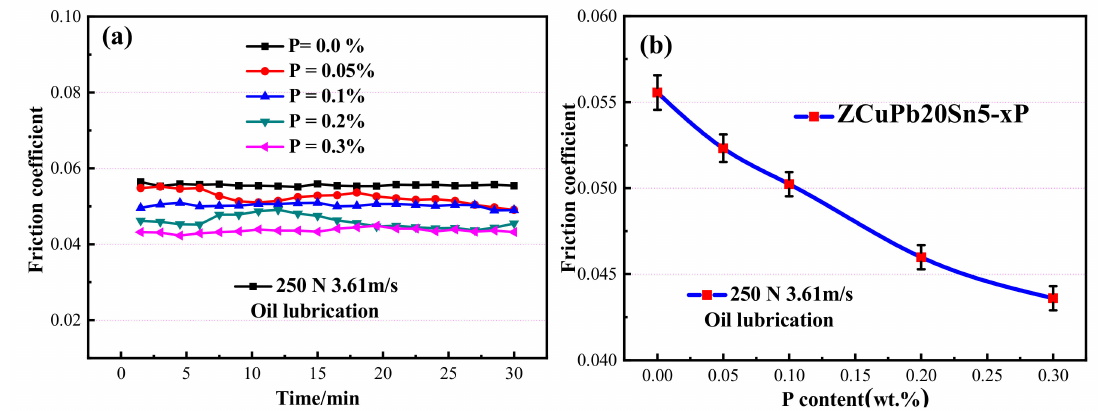
Figure 1. Friction curve of ZCuPb 20 Sn 5-x P alloy under oil lubrication ( a ) time; ( b ) P